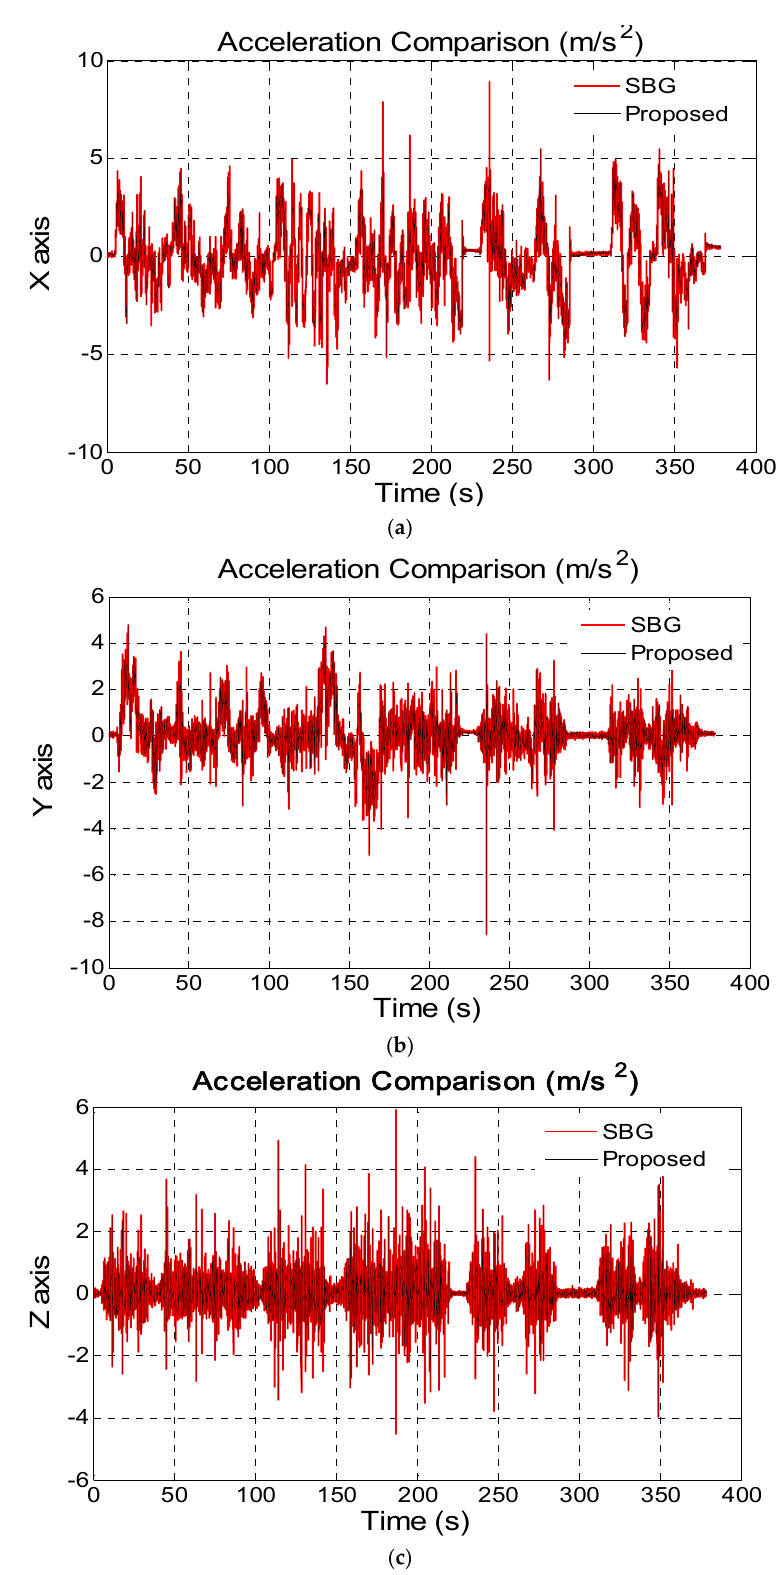
Figure 7. ( a ) X axis disturbance acceleration estimation on body frame in the kinematic vehicle experiment; ( b ) Y axis disturbance acceleration estimation on body frame in the kinematic vehicle experiment; ( c ) Z axis disturbance acceleration estimation on body frame in the kinematic vehicle experiment.